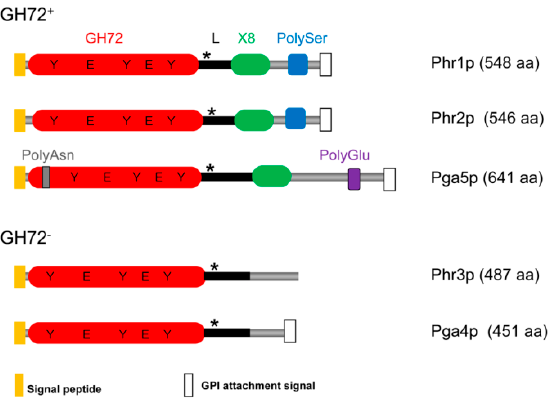
Figure 2. The Phr family of proteins includes members of the GH72 + and GH72 − subfamilies. The asterisk ( * ) indicates the conserved cysteine residue of the linker region (L). The presence of an X8/CBM43 domain defines the GH72 + subfamily. The catalytic glutamic acid residues and a triad of conserved tyrosines are indicated.